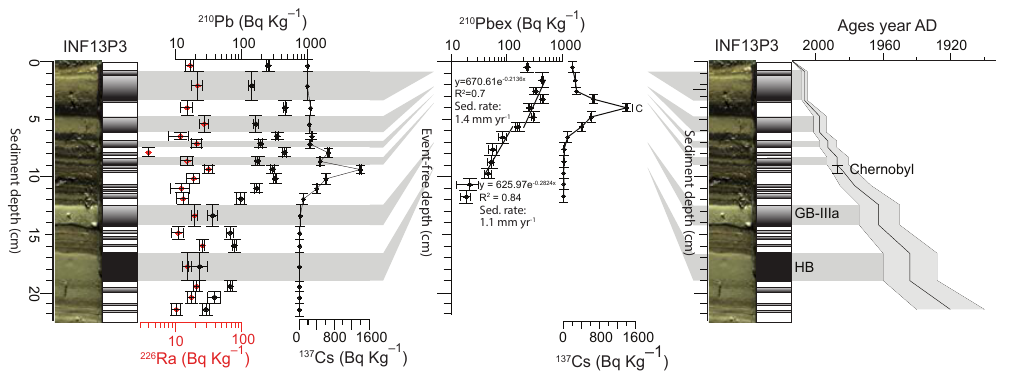
Figure 5. 226 Ra, 210 Pb and 137 Cs profiles for core INF13P3 (left). Application of a CFCS model to the event-free sedimentary profile of 210 Pbex and the resulting age–depth relationship with 1 σ uncertainties and locations of the historic 137 Cs peak of Chernobyl (1986) supporting the 210 Pb-based ages.